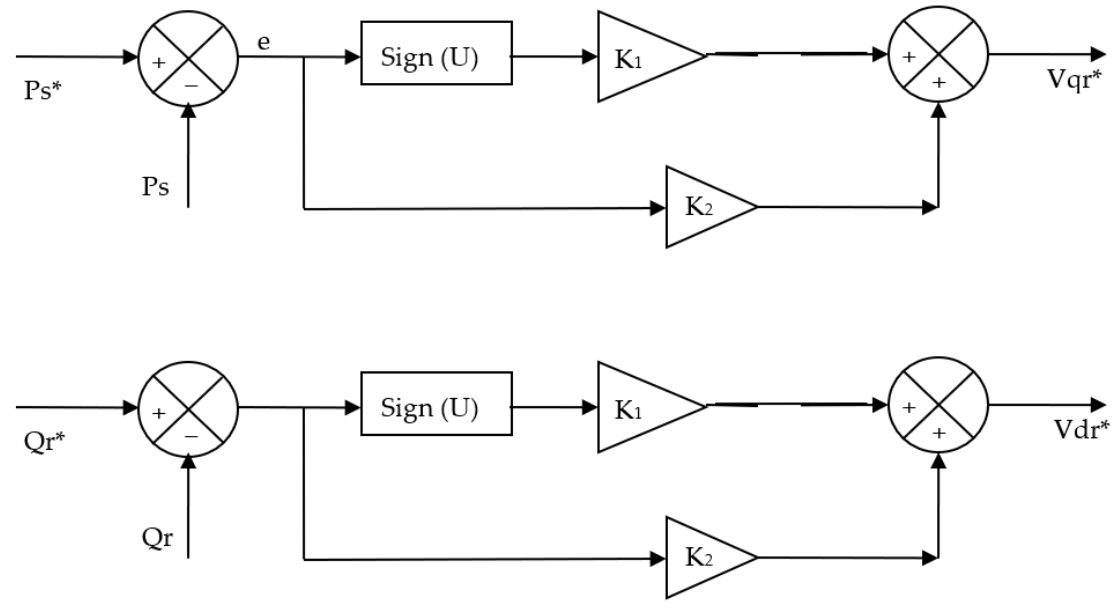
Figure 6. Block diagram of the MSMC active and reactive power controllers. Table 3. Comparative study between the classical DPC strategy and the designed DPC-MSMC tech- nique.